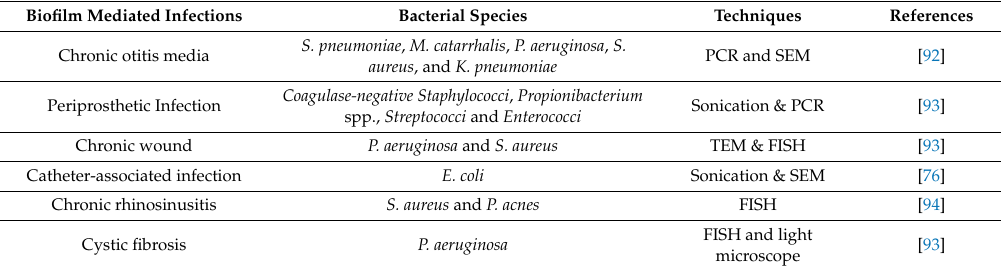
Table 3. The common laboratory techniques applied for laboratory diagnosis of biofilm mediated